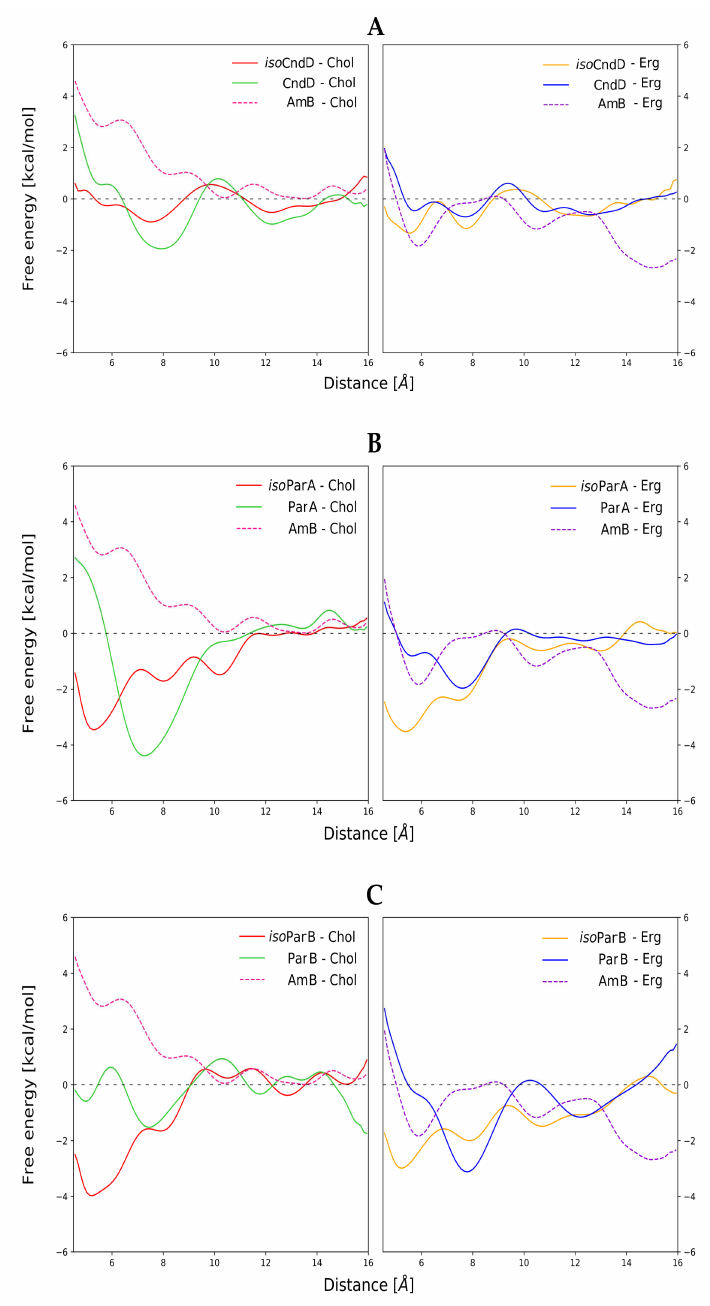
Figure 2. Free energy profiles of all studied antibiotic/sterol systems in lipid bilayer environments. Horizontal axes stands for distance between centers of masses between respective sterol and macro- lactone ring. ( A ) Data for Candicidin D (CndD) and iso CndD, related to Amphotericin B (AmB). ( B ) Data for Partricin A (ParA) and iso ParA, related to AmB. ( C ) Data for Partricin B (ParB) and iso ParB, related to